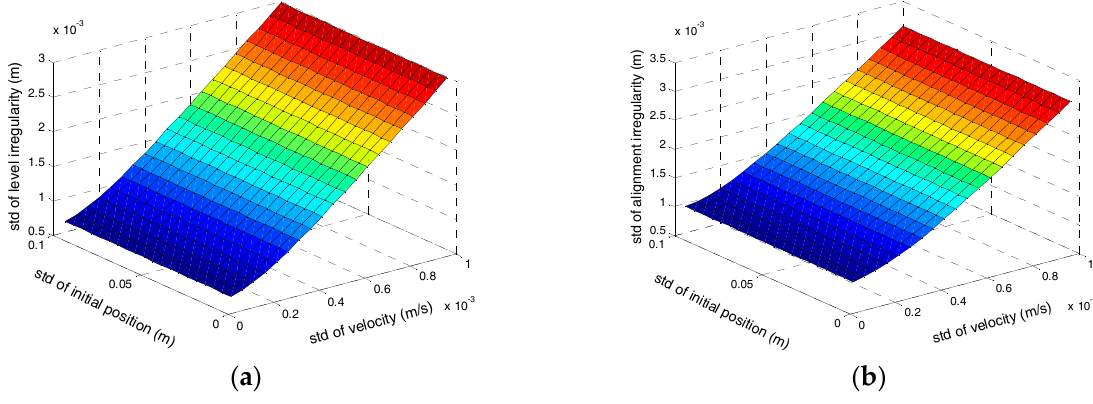
Figure 8. ( a ) The relationship between level irregularity and accuracy of velocity observation as well as initial position; ( b ) The relationship between alignment irregularity accuracy and accuracy of velocity observation as well as initial position.